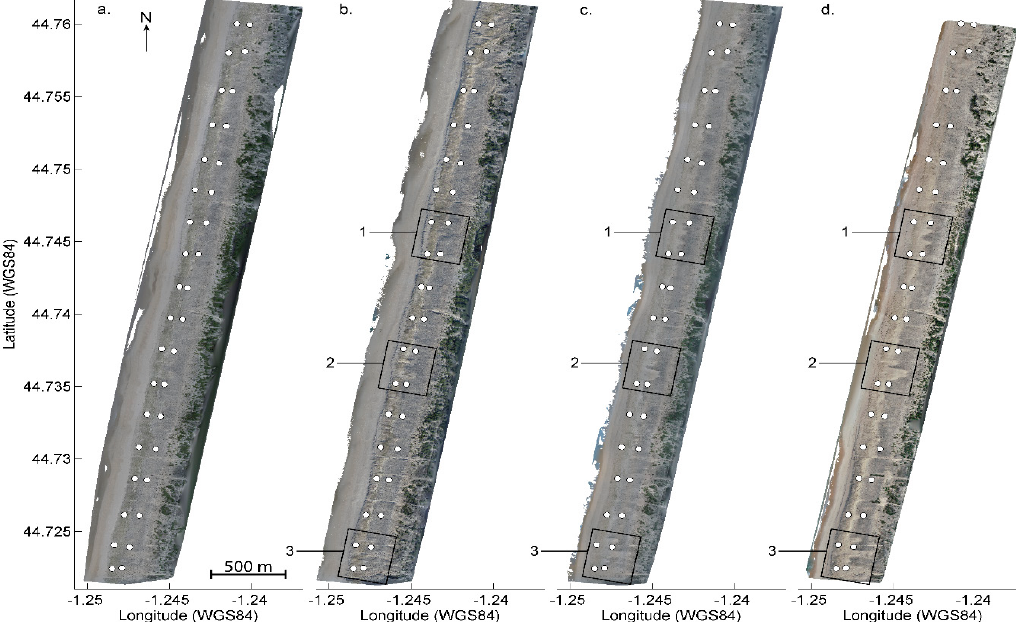
Figure 6. Orthophotos of the entire 4-km study area of Truc Vert beach on ( a ) 9 October 2017, ( b ) 19 December 2017, ( c ) 23 January 2018 and ( d ) 13 March 2018. The positions of the 36 permanent GCPs implemented in 250-m spaced pairs along the entire 4-km dune system used for the DSM generation are indicated by white dots and the black squares show the areas zoomed onto in Figure 7.